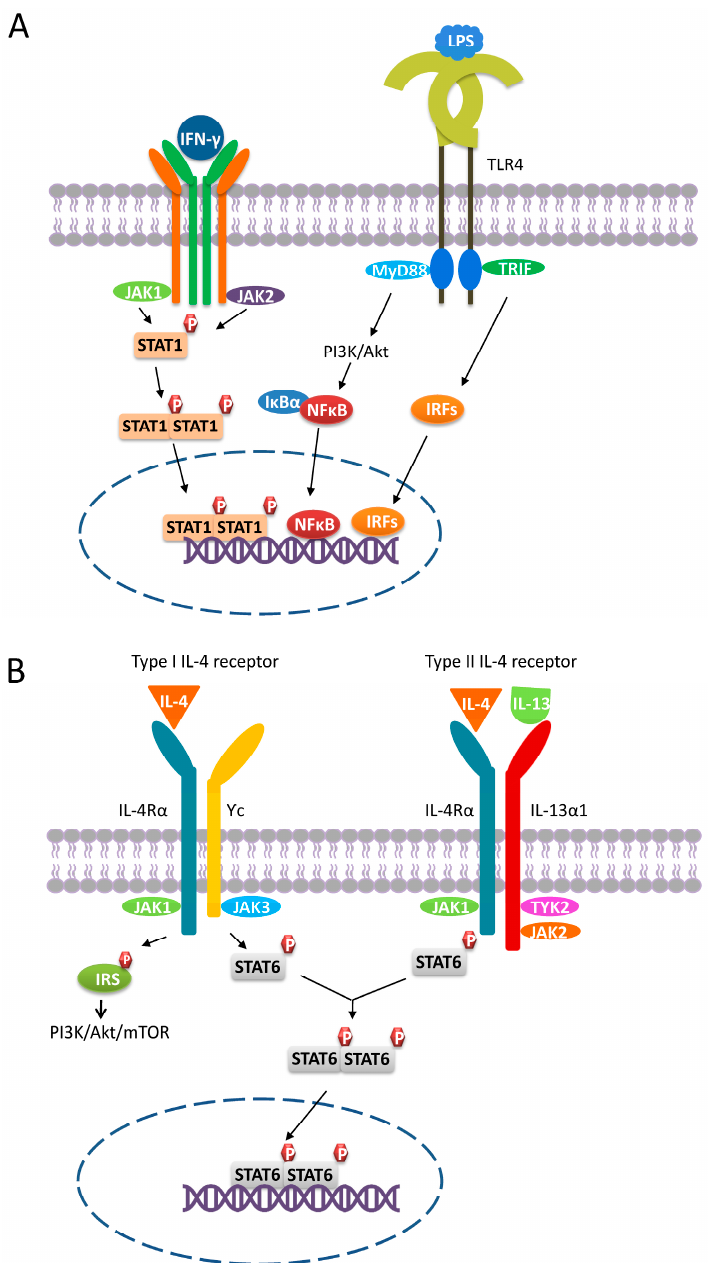
Figure 1. M1 and M2a polarization. ( A ) M1 macrophages polarize through signaling pathways mediated by STAT1, PI3K/Akt, NF κ B, and IRFs. Binding of IFN- γ to its receptor leads to the recruitment of JAK1 and JAK2, inducing the phosphorylation of STAT1, which then dimerizes and translocates into the nucleus. In response to the LPS-TLR4 engagement, PI3K/Akt-, NF κ B-, and IRFs-mediated signaling are triggered. ( B ) M2a macrophages polarize through the PI3K/Akt- and STAT6-mediated signaling pathways. Macrophages express both type I and type II IL-4 receptors. The